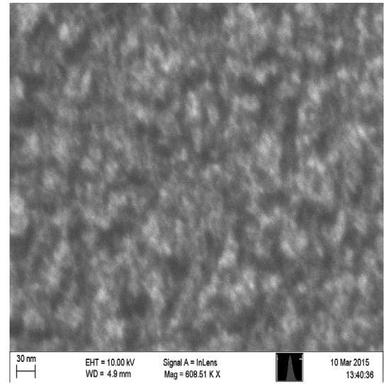
Scanning electron micrograph of the surface of a 1700-nm-thick NiO film (Sample 1) annealed at 400 °C.